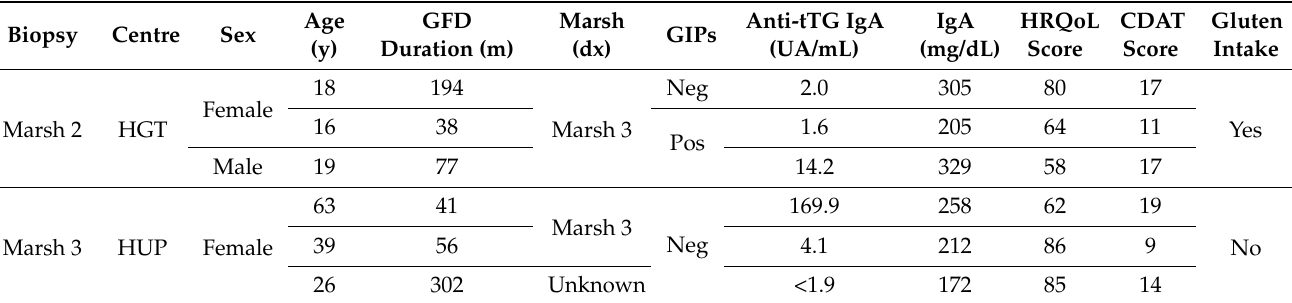
Table 3. Demographic data, clinical characteristics, and laboratory results for patients with Marsh type 2/3 in the duodenal